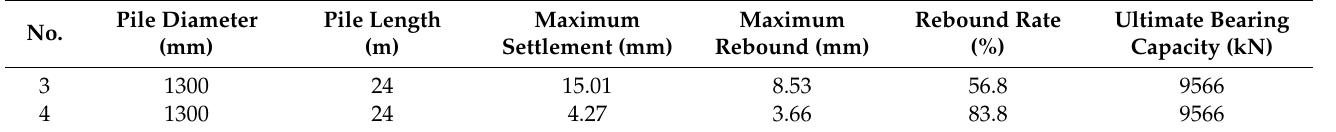
Table 4. Summary of vertical static load test results of a single pile.